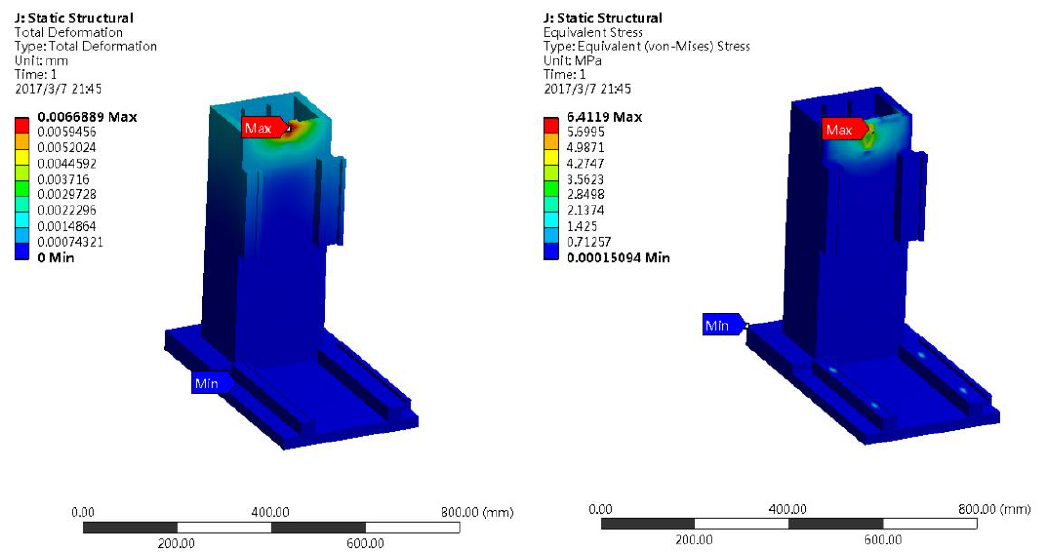
Figure 11. Static deformation and stress at the lower limit of the integral structure.